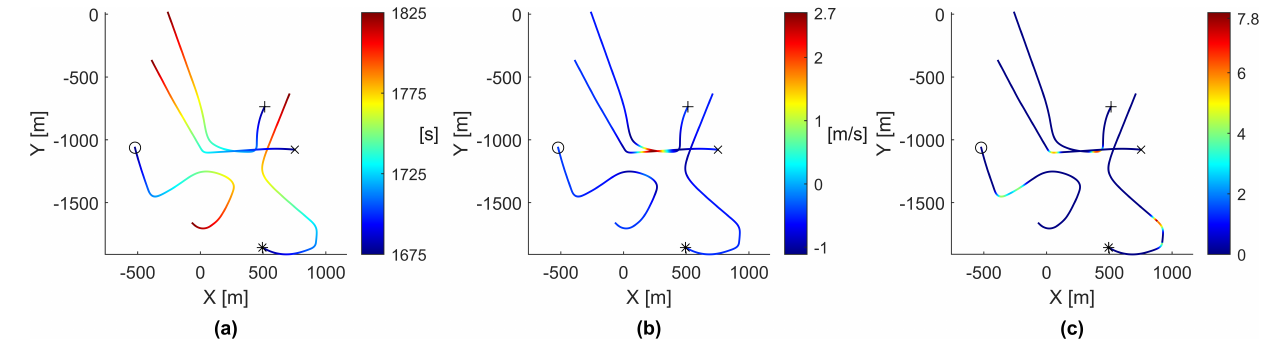
Figure 8. Paths of agents 9, 11, 27, and 29, as they fail to effectively discover a thermal updraft, viewed from a top-down perspective. Agent 9 is marked with an ‘x’, agent 11 with an ‘o’, agent 27 with an ‘*’, and agent 29 with a ‘+’. The rendered path data starts at 1675 s and continues until 1825 s. ( a ) The paths colored by time in seconds. ( b ) The paths colored by vertical velocity in meters per second. ( c ) The paths colored by cohesion magnitude to surrounding agents.